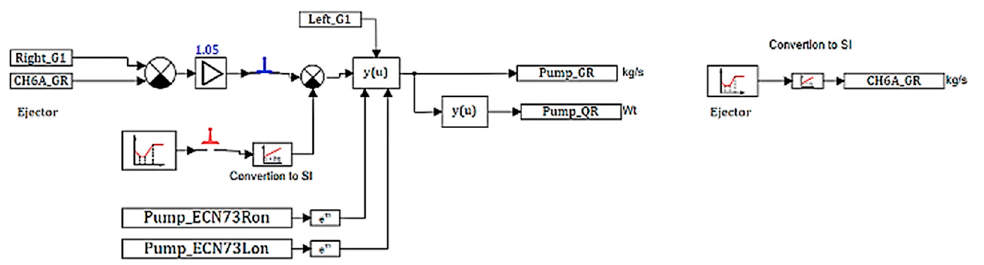
Figure 3. Example of design code of a hydraulic unit.